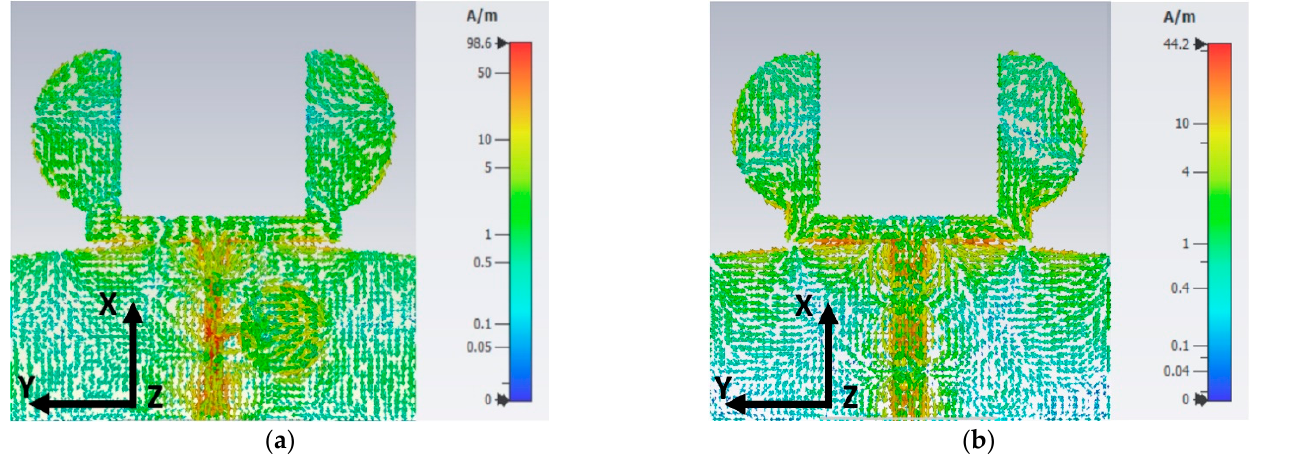
Figure 13. Current distributions at 10 GHz for the UWB antenna array: ( a ) Antenna array with single-wing filter, ( b ) Antenna array without filter.